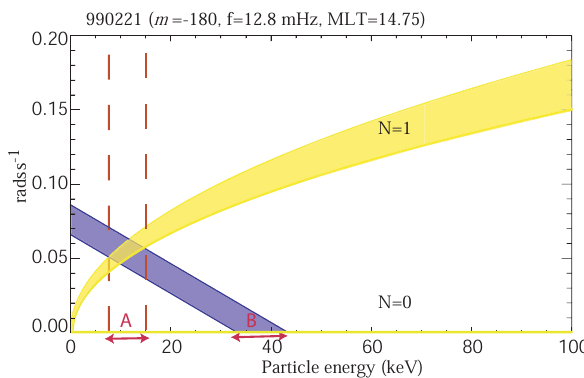
Fig. 5. A graphical representation of the drift-bounce resonance condition (see text for details). It can be seen that the two shaded areas intersect at two locations. If free energy is available to the wave at these interaction energies in the form of a positive gradient in the IDF, then the particle population can provide energy for that wave mode. Particles of energy A represent those which could drive the wave through a drift-bounce resonance interaction while those of energy B could drive the wave through a drift